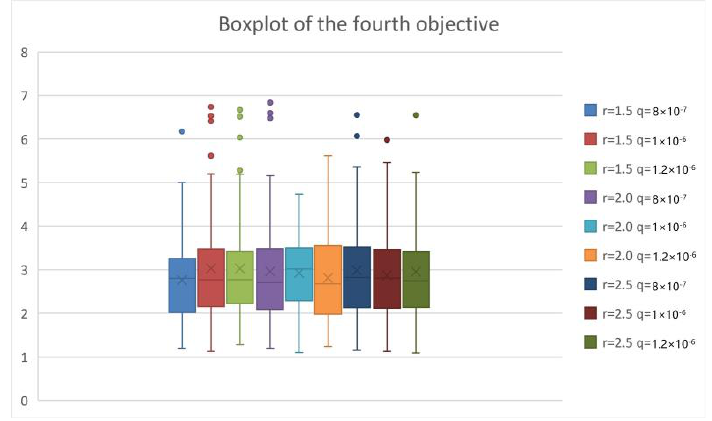
Figure 12. Boxplot chart of criteria of equitable distribution.